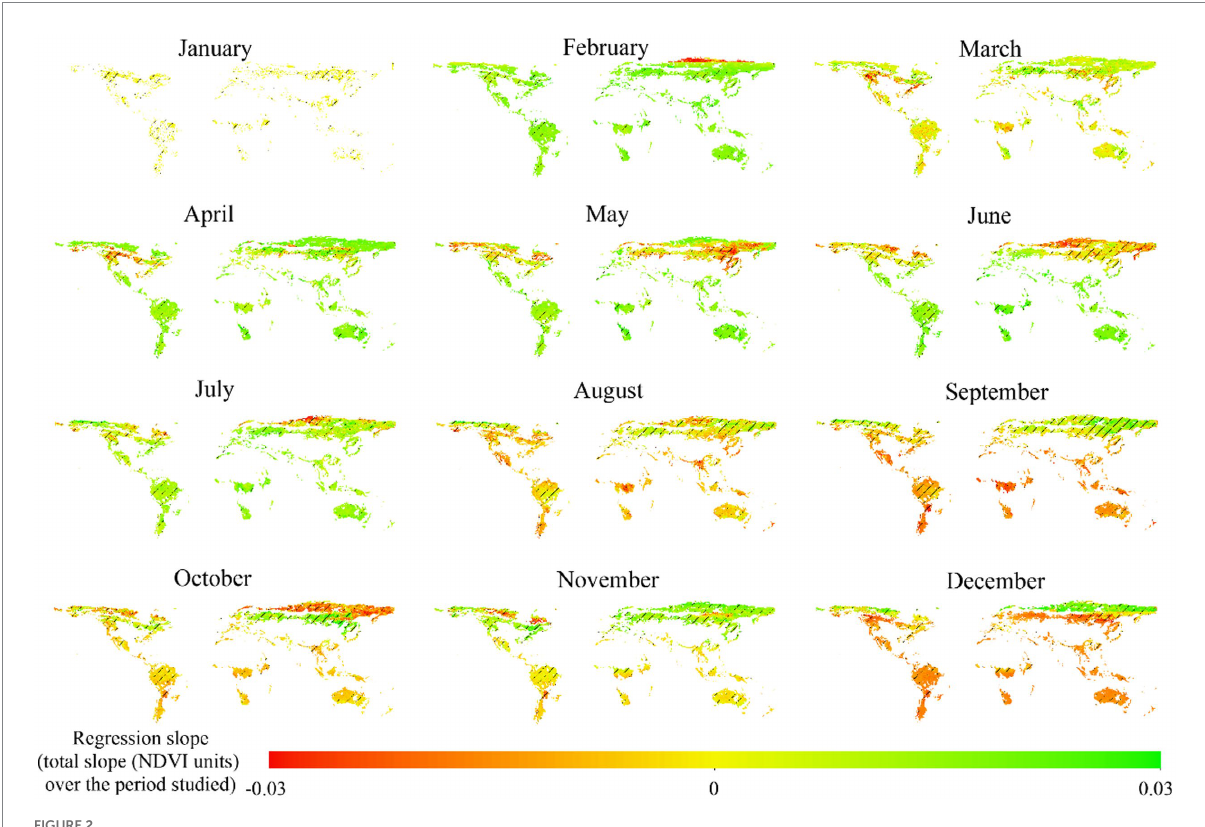
FIGURE 2 Variation of global woodland NDVI from 1981 to 2015 (slash represents the MK test passing 95% confidence interval).